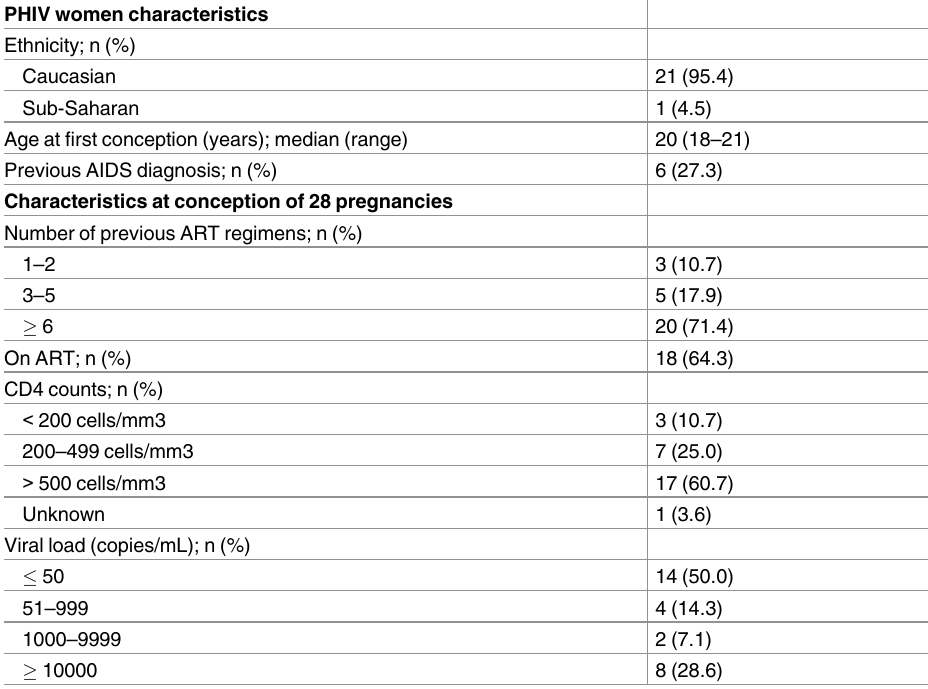
Table 1. Characteristics of 22 perinatally HIV-1 infected women at